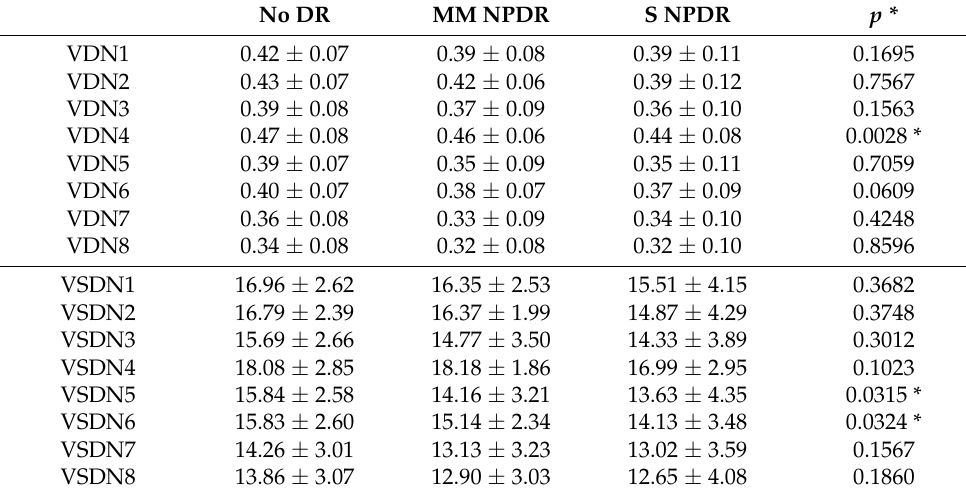
Figure 4. Mean vessel density with standard deviation for each group (without DR, mild and moderate NPDR, and severe NPDR) in zone 4. ** p < 0.01. DR, diabetic retinopathy; MM NPDR, mild and moderate non-proliferative diabetic retinopathy; S NPDR, severe non-proliferative diabetic retinopathy. Table 2. Vessel density (VD) and vessel skeleton density (VSD) in each area of the ETDRS grid in the nasal area. DR, diabetic retinopathy; MM NPDR, mild and moderate non-proliferative diabetic retinopathy; S NPDR, severe non-proliferative diabetic retinopathy.* p < 0.05. No